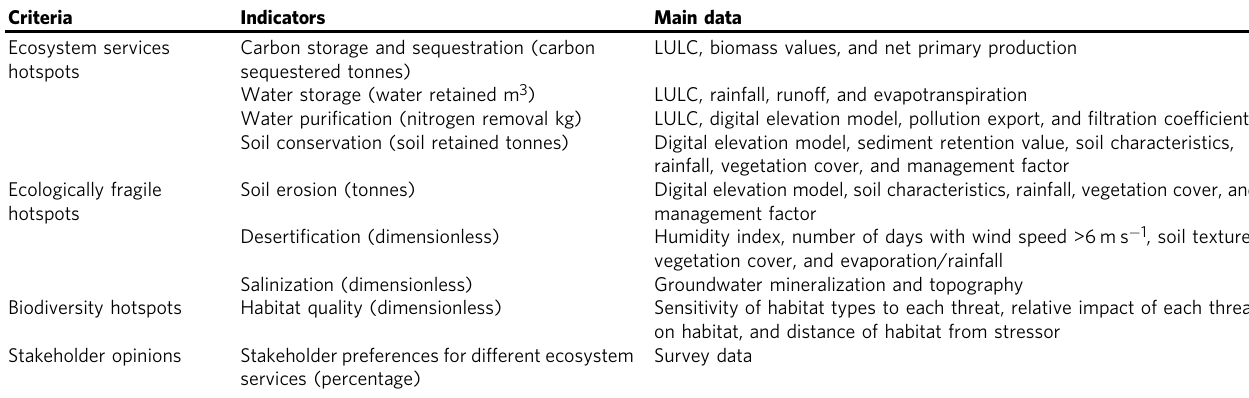
Stakeholder opinions Stakeholder preferences for different ecosystem services (percentage)